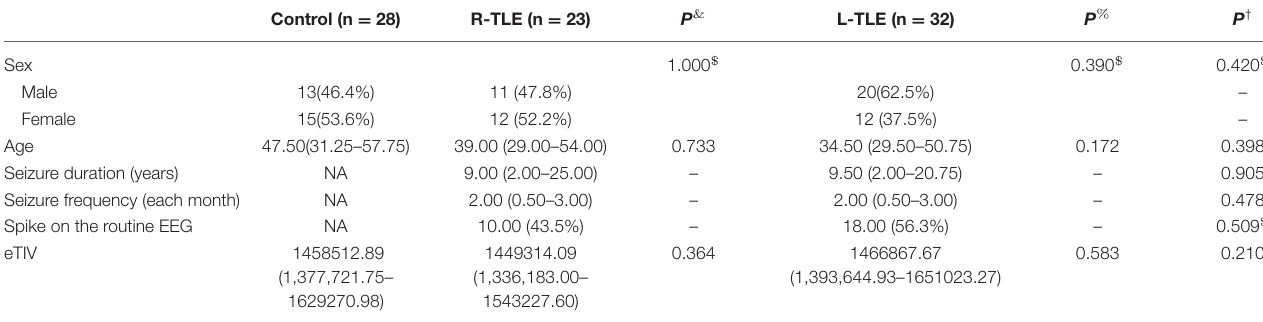
TABLE 1 | Demographic characteristics of control, R-TLE, and L-TLE groups.